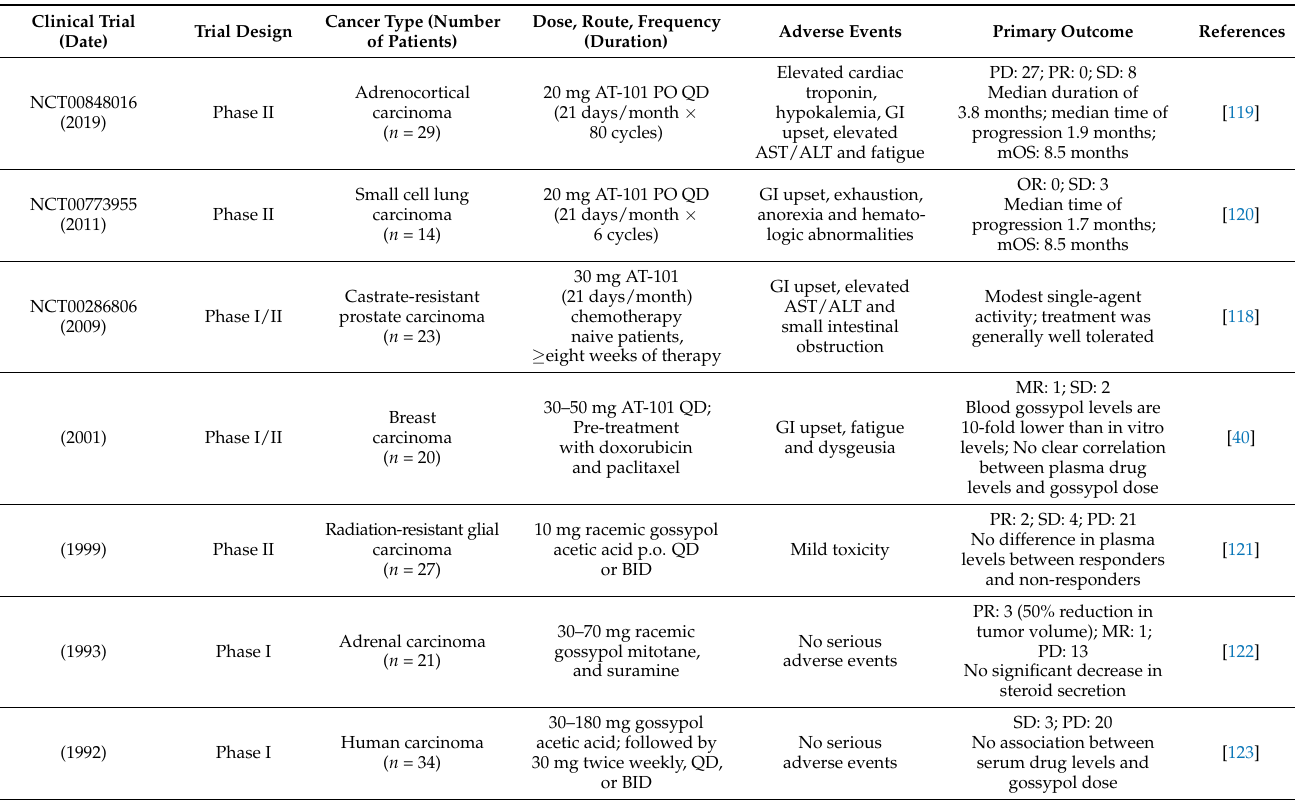
Table 5. Oral application of single-agent gossypol/AT-101 investigated in cancer patients in Phase I and II